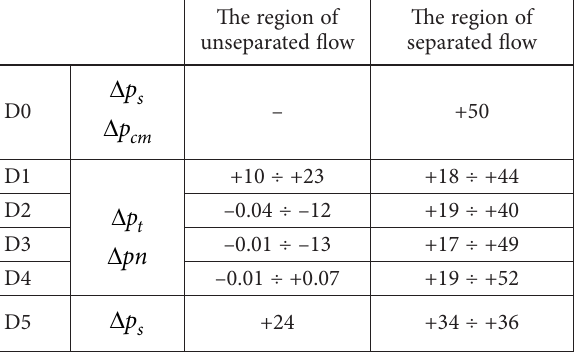
Table 3. Calculation error of flow parameters (%) The region of The region of unseparated flow separated